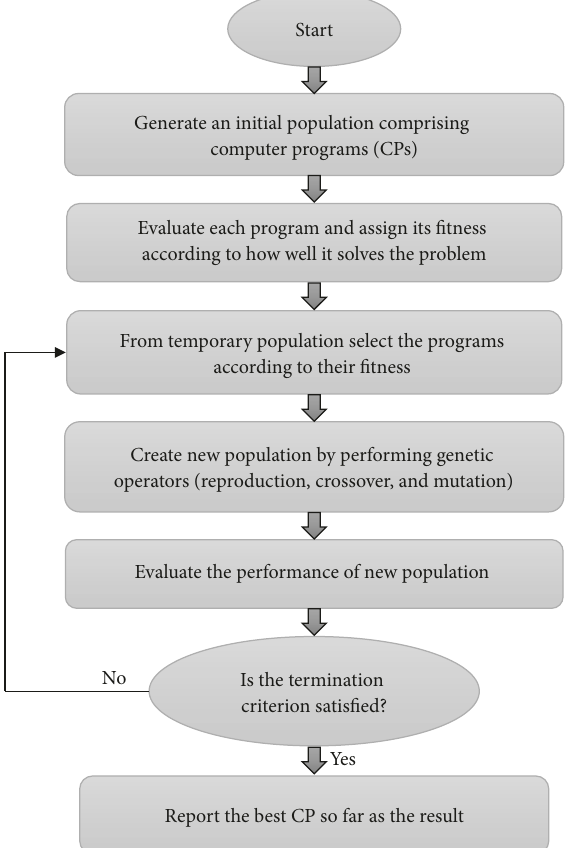
Figure 2: Genetic programming